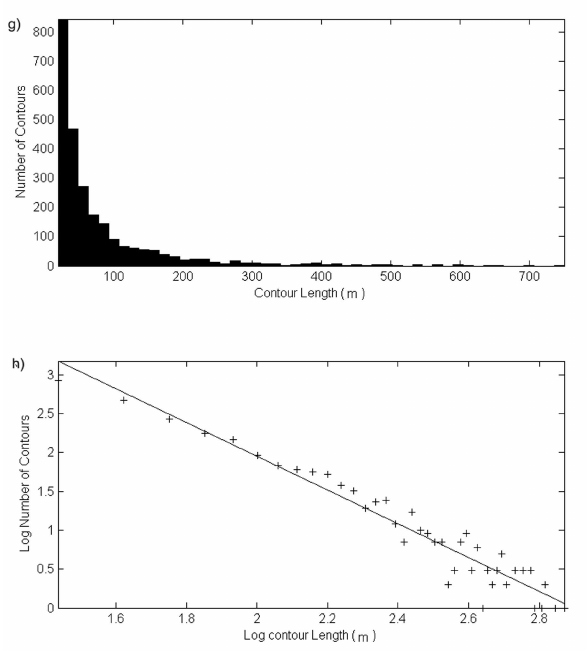
Fig. 1g, h. Histogram and log-log histogram of the lengths of the edge contours in Fig. 1b. A fitted power–law distribution is shown as a solid line.